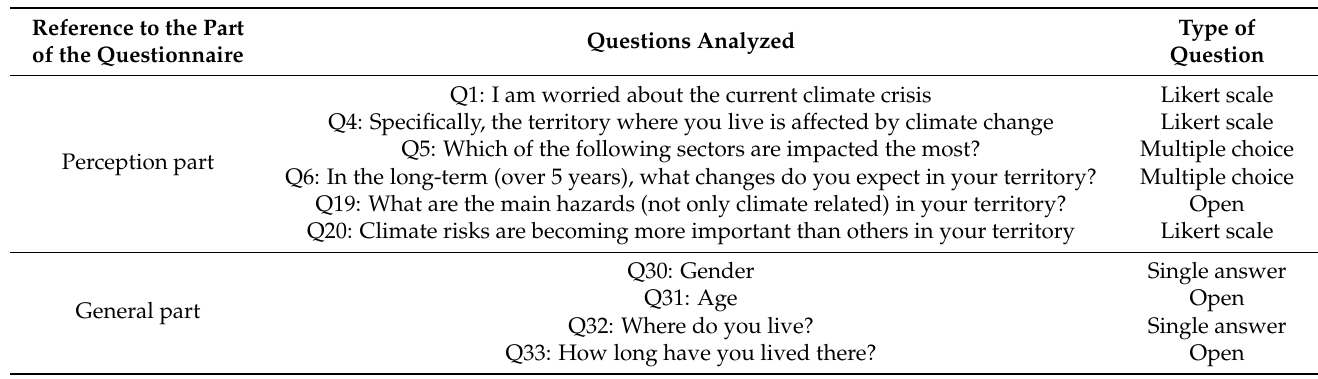
Questions Analyzed